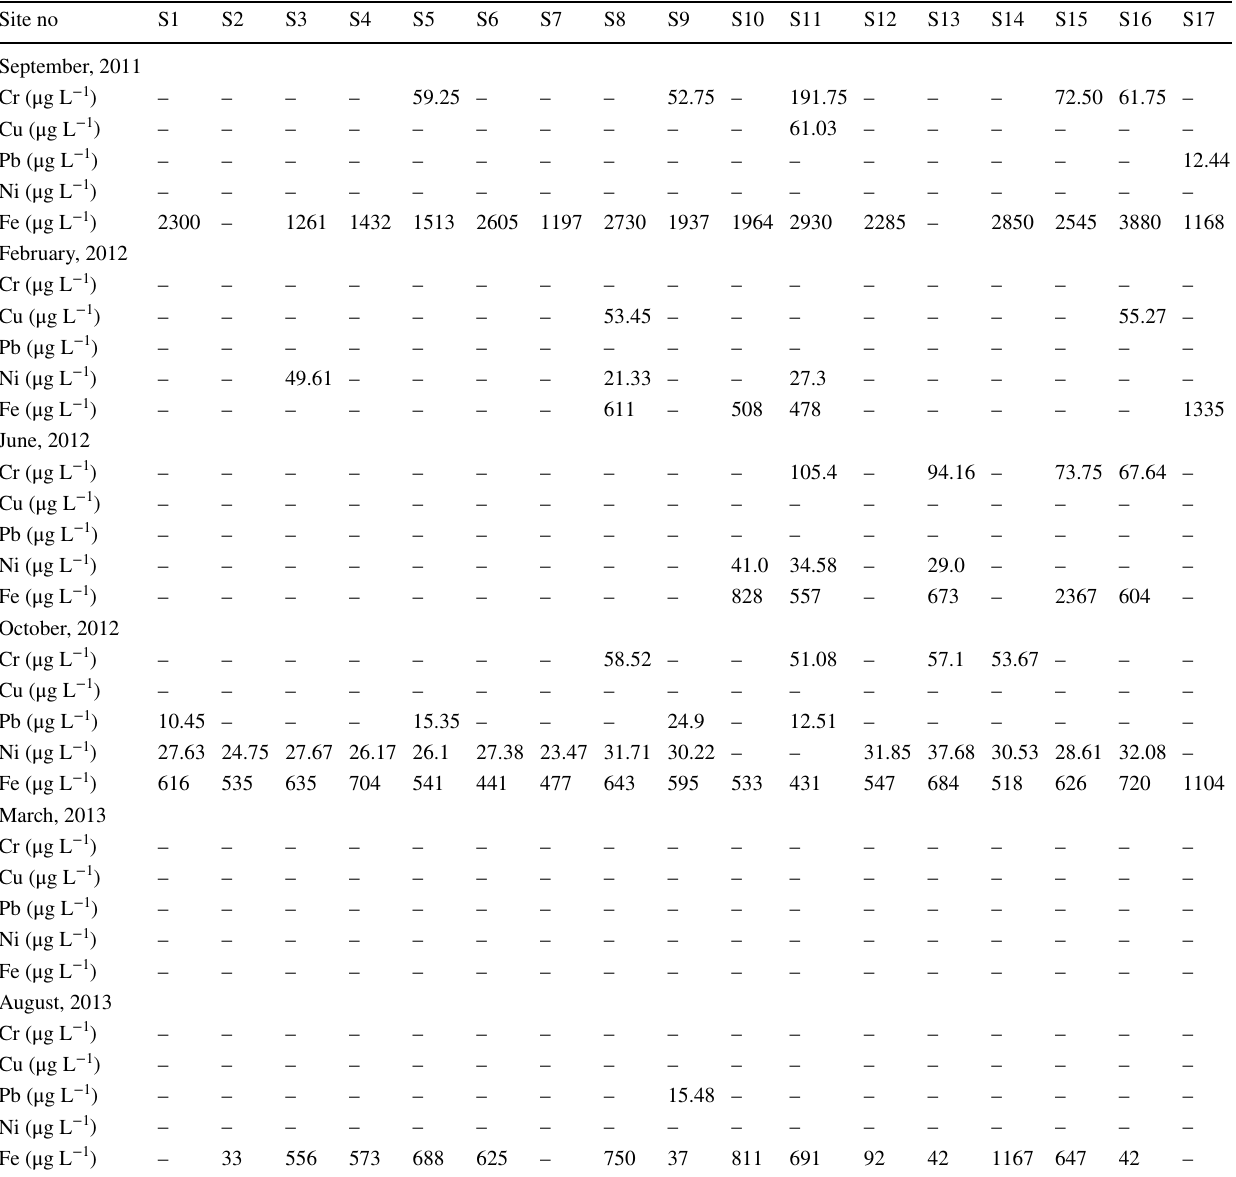
Table 3 WQ hotspots in River Mahanadi and tributaries Site